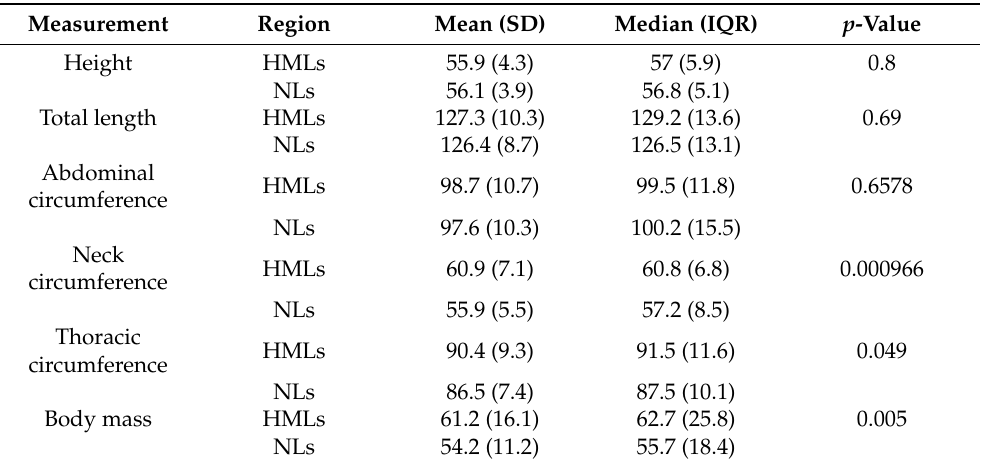
Table 3. Comparison of biometric parameters between capybaras from human-modified landscapes (HMLs) and natural landscapes (NLs).